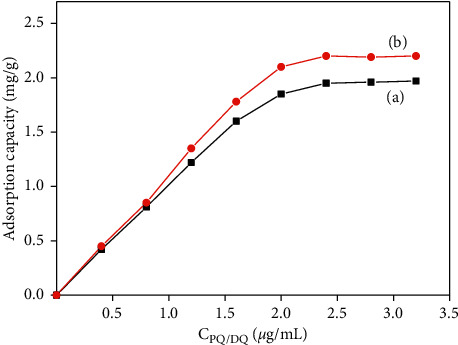
Adsorption capacity of CoFe2O4@SiO2 to PQ (a) and DQ (b).